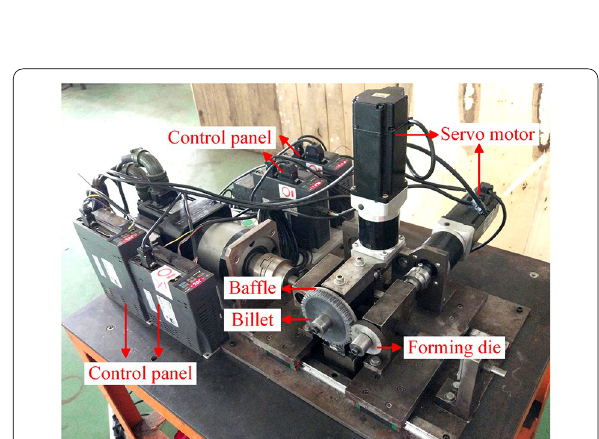
Figure 12 Experimental setup for successive tooth